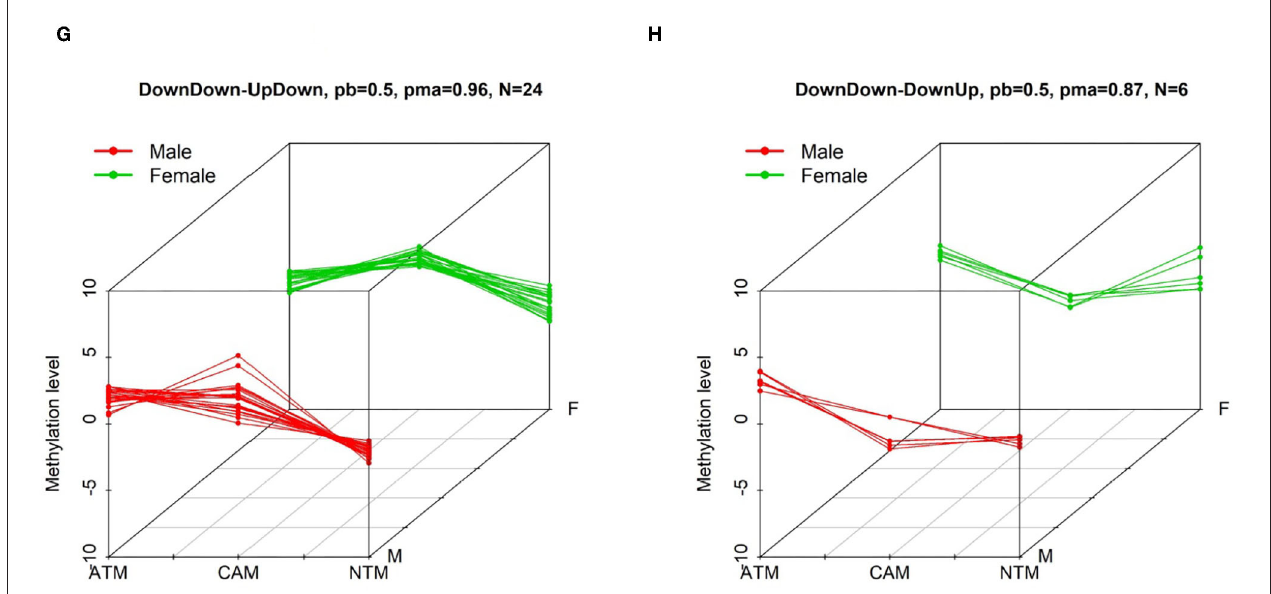
FIGURE 2 | The first 6 three-dimensional patterns of differential methylation levels. Two other patterns are shown below. Three-dimensional patterns of differential methylation levels. Eight patterns (A–H) with differential methylation levels between three groups (CAM, ATM, and NTM) when comparing male to female samples were identified by BACkPAy. Each group contains three samples (one male and two female samples or two male and one female samples). In each panel, N represents the number of differential methylation level probes belonging to one specific pattern with probability larger than pb = 0.5. pma is the maximum probability to belong to the corresponding